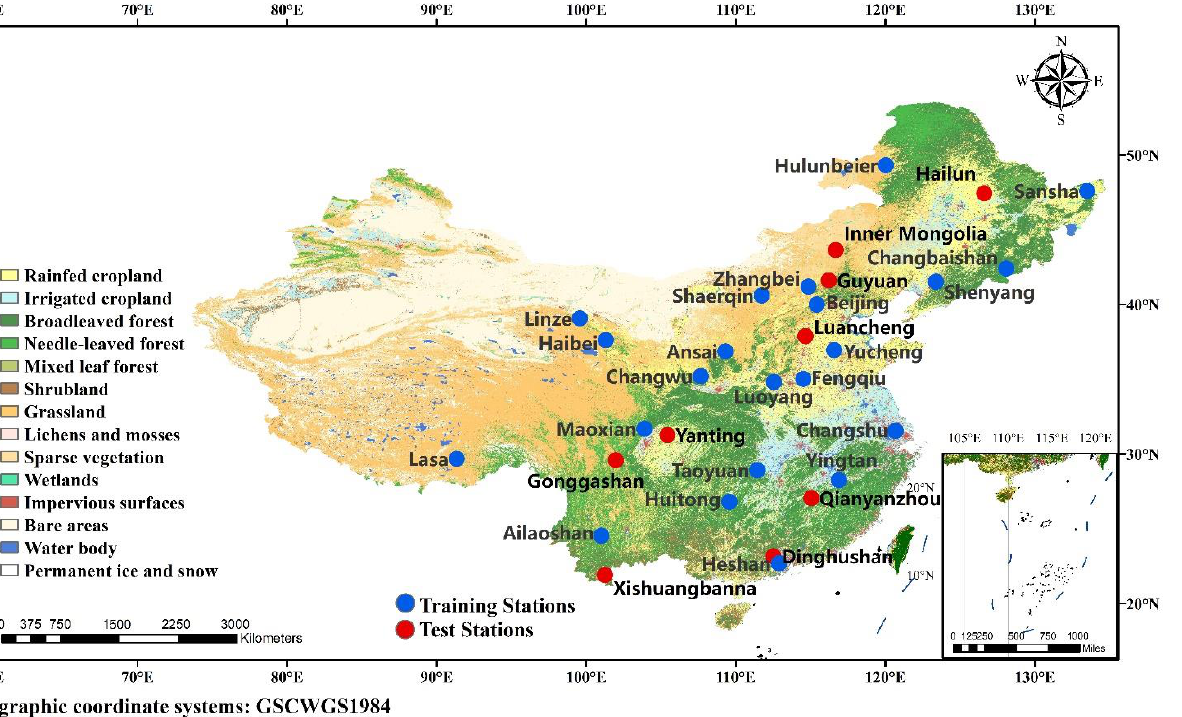
Figure 1. The distribution of Machine Learning stations: they are national field observation stations in China; the blue points represent training stations, and the red points represent test